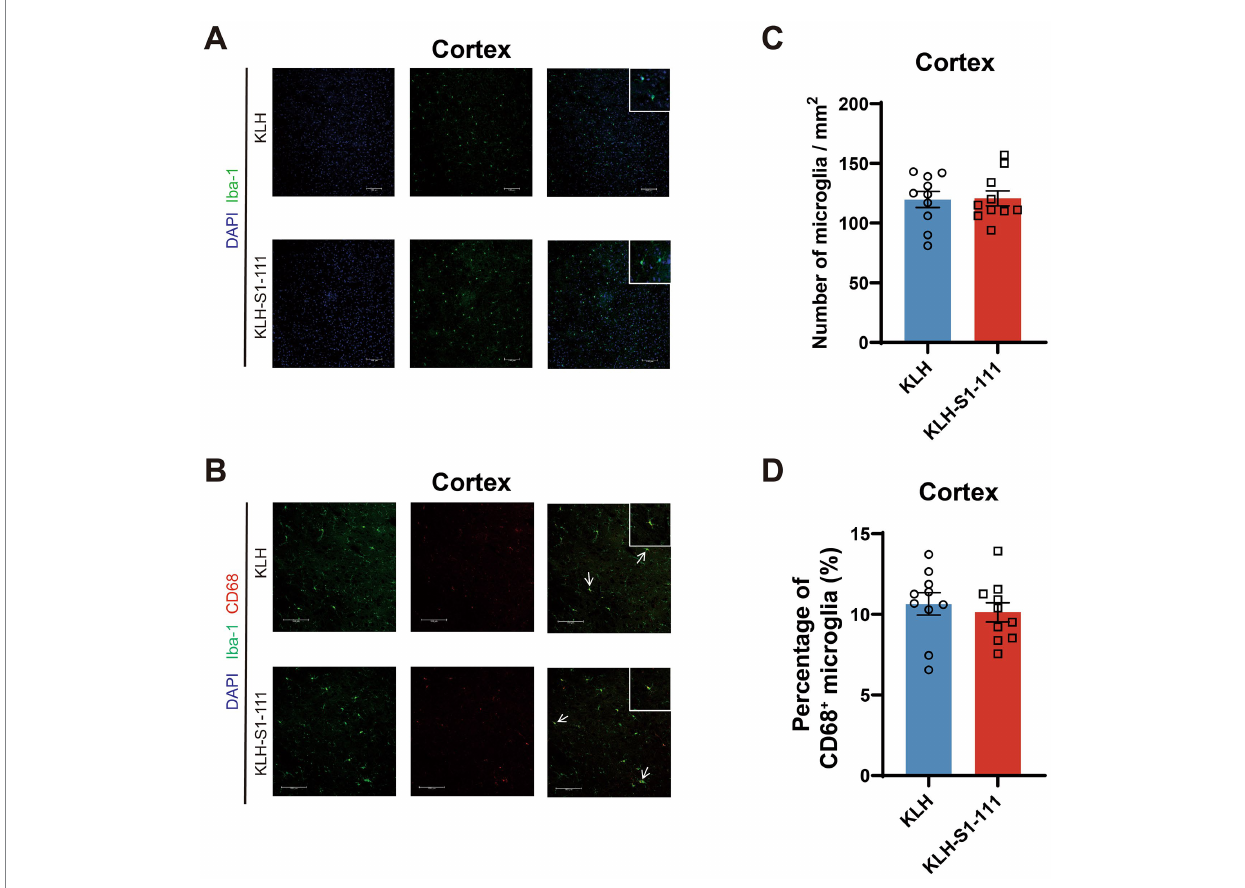
FIGURE 3 Evaluating of the effect of endogenous anti-S1-111 antibodies on cortical glial cells. Representative images depicting immunofluorescence staining in the cortex (A) for Iba1 + microglia, and (B) for Iba1 + and CD68 + microglia. Magnification 20× objective field with 100 μ m scale bars for A and B; white boxes indicate the enlarged insert of a representative cell with 10 μ m scale bars. (C) Quantification of Iba1 + microglia. (D) Quantification of Iba1 + and CD68 + double-positive area in Iba1 + area. (C,D) . N = 10/group, unpaired Student’s t test, data are shown as the mean ±